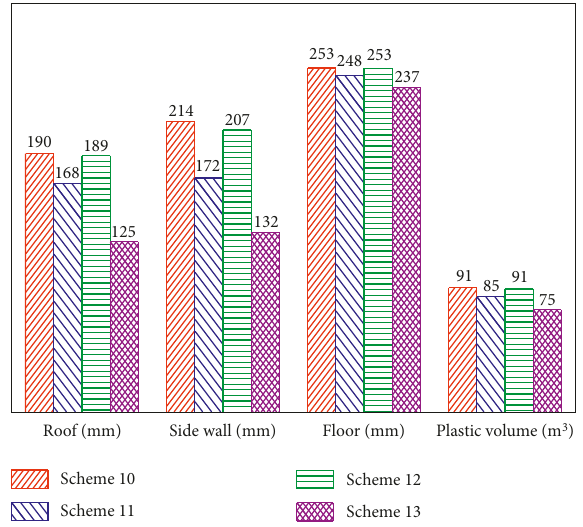
Figure 11: The comparative columns of roadway deformations and plastic zones of Schemes